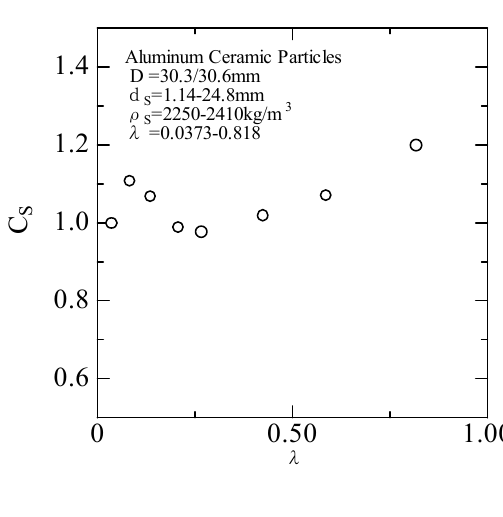
Fig.3 Solid distribution